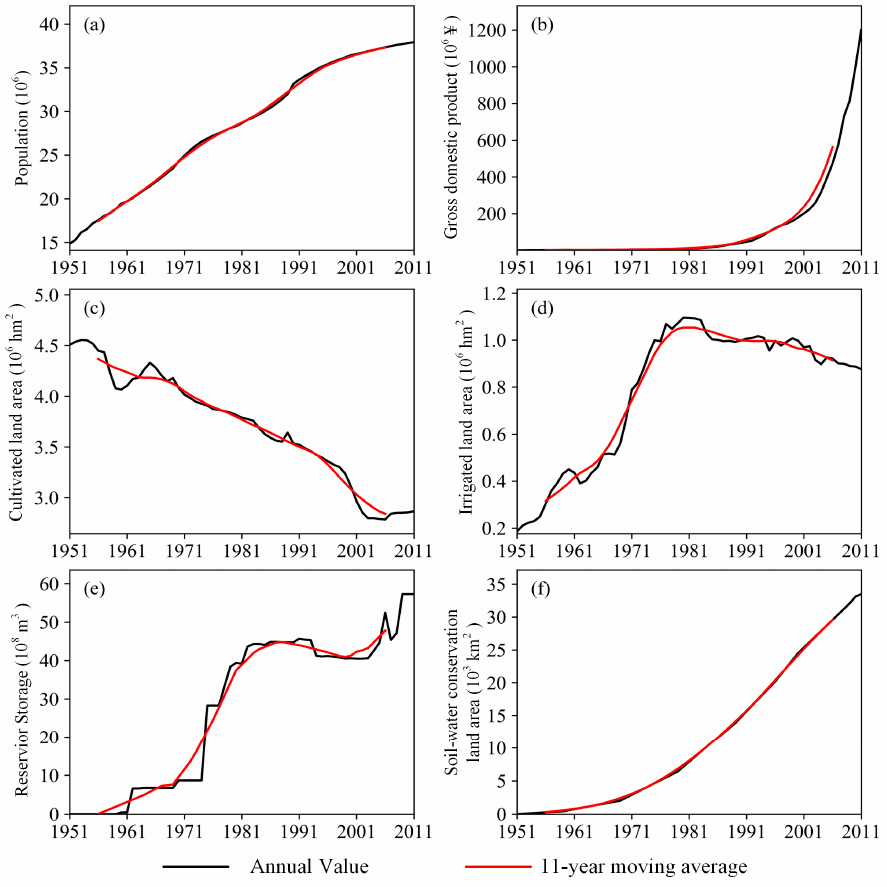
Figure 2. Annual and the 11-year moving average value of 6 covariates related to human activities. ( a – f ) represent population, gross domestic product, cultivated land area, irrigated land area, reservoir storage and soil-water conservation land area, respectively.